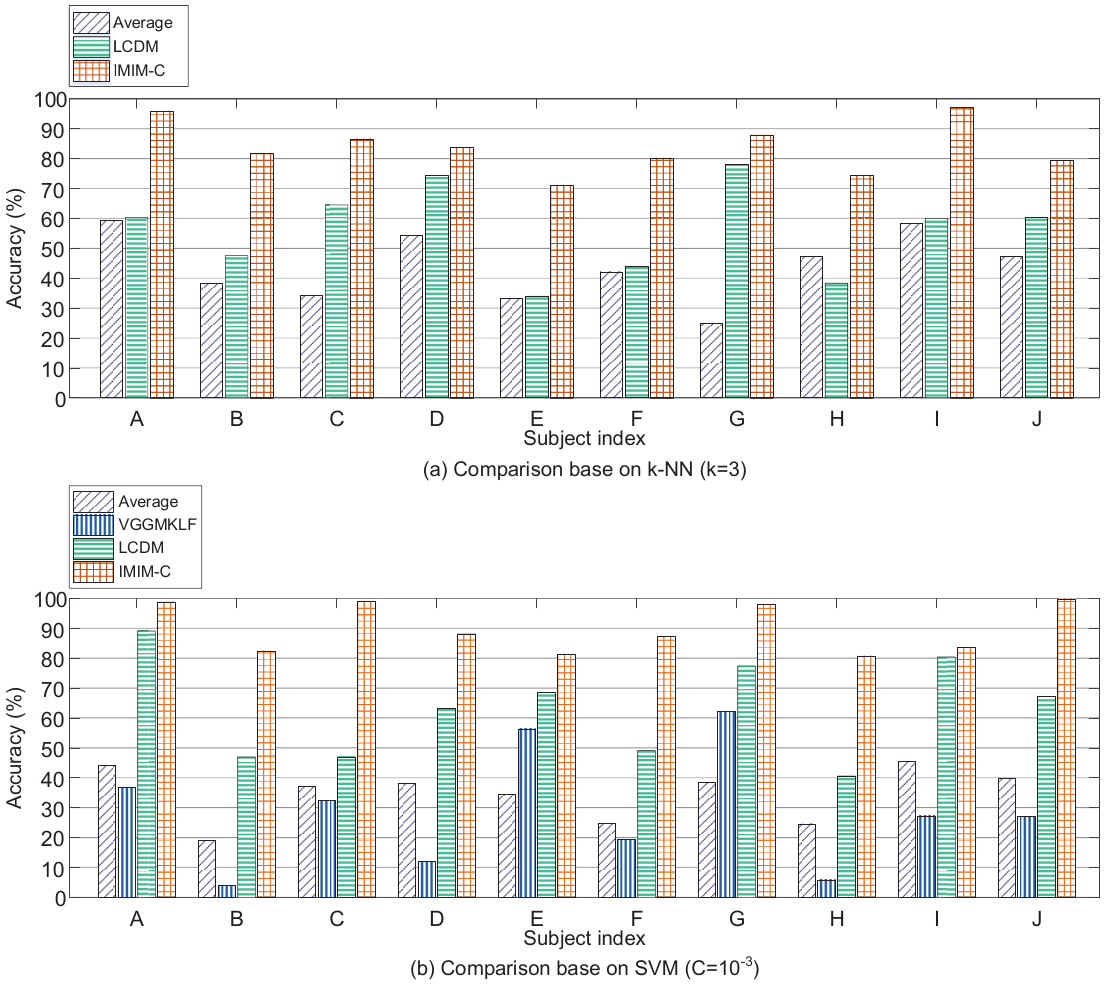
Figure 11. Comparison of classifier level fusion methods according to 10 subjects involved in this experiment. The subjects are numbered from A to J randomly.